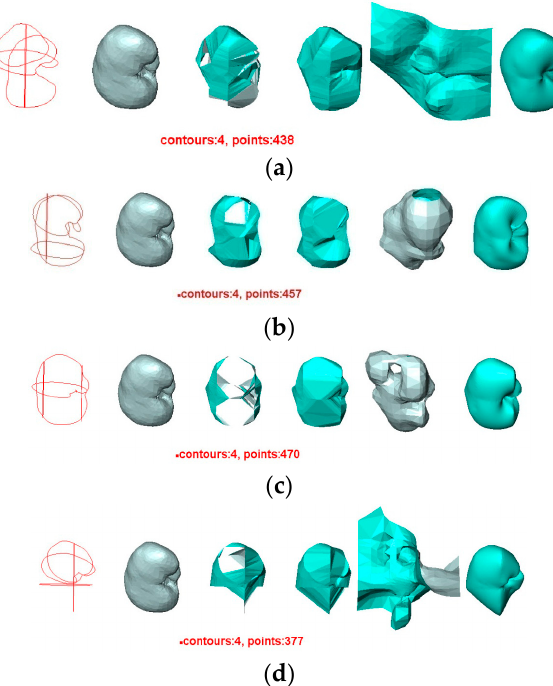
Figure 10. Surface reconstruction of a human kidney by four methods. The number of contours are the same in different rows, but the contours were drawn by different users: ( a ) User 1; ( b ) User 2; ( c ) User 3; ( d ) User 4. For each row, from left to right: the contours used, the original surface, the surface reconstructed by BPA, the surface reconstructed by Power Crust, the surface reconstructed by Poisson, and the surface reconstructed by VSR.